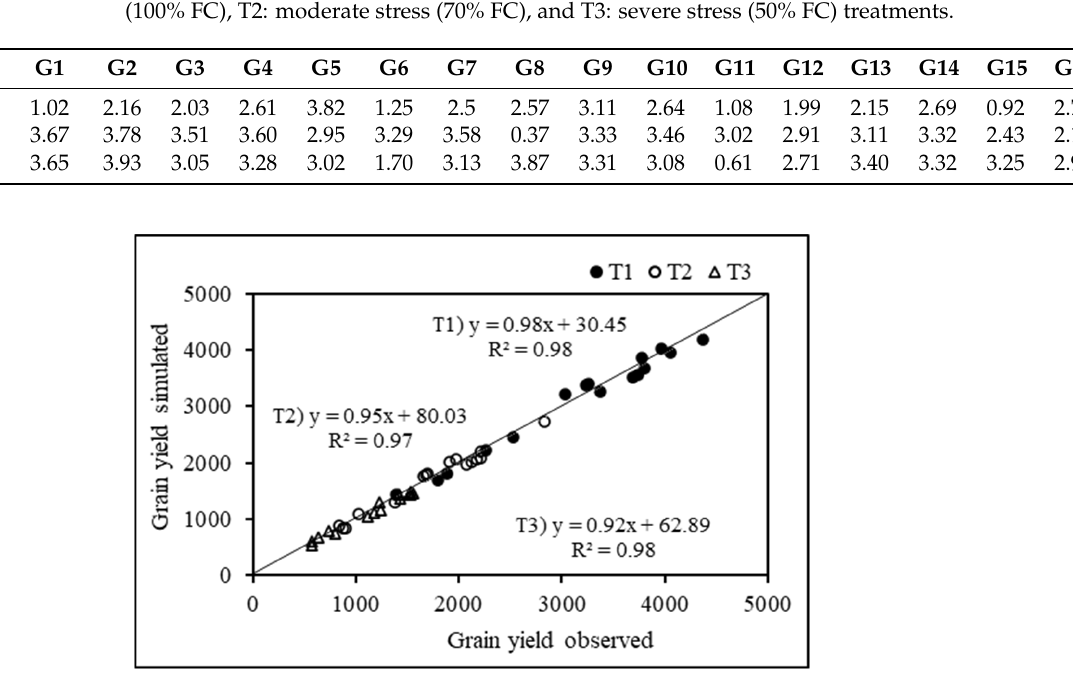
Figure 6. Comparison of the simulated versus observed grain yield (kg ha –1 ) for sixteen upland rice genotypes under T1: control (100% FC), T2: moderate stress (70% FC), and T3: severe stress (50% FC) treatments in the yield assessment experiment.